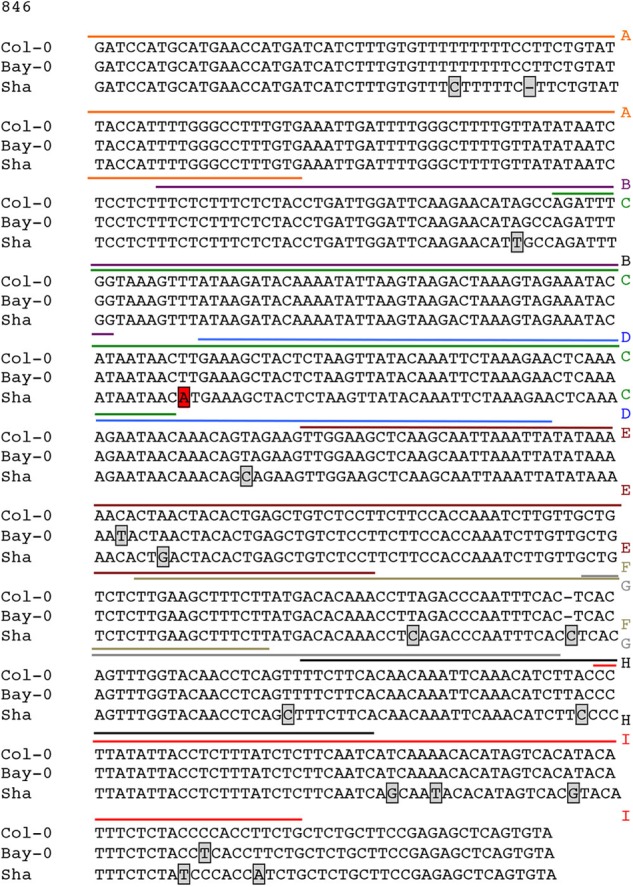
Sequence analysis of promoter of CESA4 for Col-0, Bay-0, and Sha accessions. Sequencing and alignment of CESA4 promoter contains only one single nucleotide polymorphism between CESA4Bay and CESA4Col and sixteen SNPs between CESA4Sha and CESA4Col. Colored lines and letter above the sequence indicate different fragments tested for affinity with NAC proteins. Boxes indicate sequence polymorphisms.